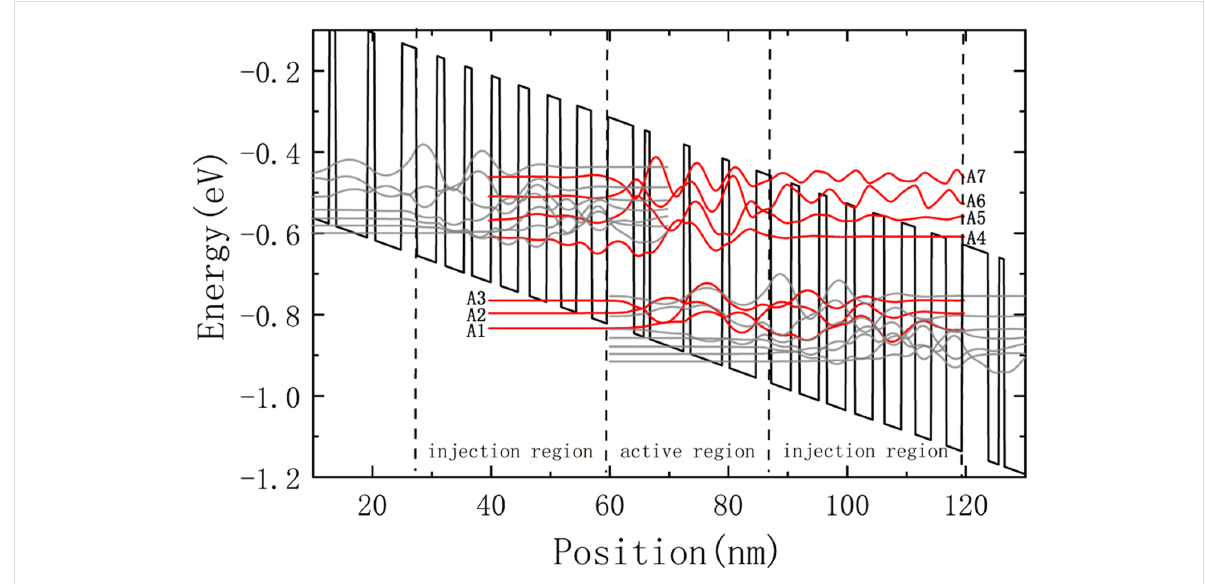
Figure 2: Calculated conduction subbands and moduli squared of relevant wave functions with a 53 kV/cm DC bias.